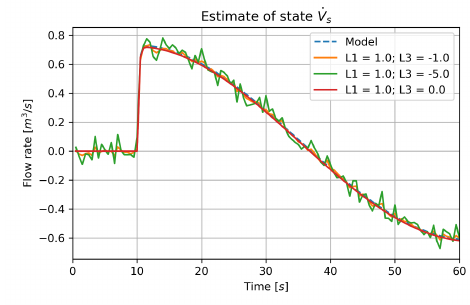
Figure 7: Observer behavior when both measurement x 1 and x 3 are injected. Gain L 3 is varied to study it’s effect on convergence.